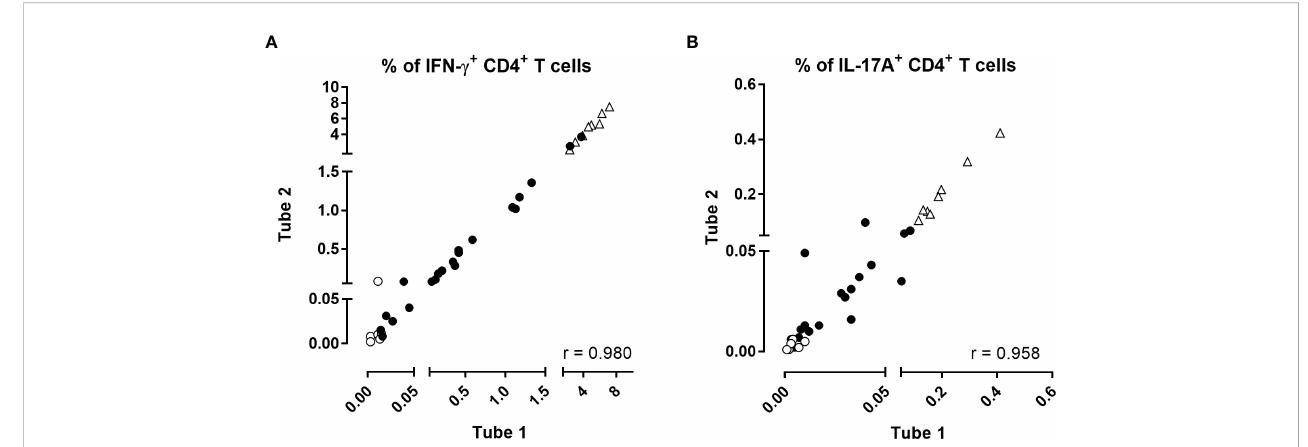
FIGURE 2 Intra-assay reproducibility of the BpWB-ICS assay. The percentages of (A) IFN- g - and (B) IL-17A-producing CD4 + T cells obtained after direct staining of two separate aliquots of blood were compared two by two for each stimulation condition. Two different aliquots (400µl/aliquot) from single blood samples were assayed separately from stimulation until the direct staining of the cells. Negative (no antigen, open circles) and positive (SEB, open triangles) controls were used in parallel to blood incubated during 24 hrs with 5 µg/ml PT, 5 µg/ml FHA, 10 µg/ml BPL, 10 µg/ml Bp sonicate or 10 µg/ml TT (black circles). Thirty- fi ve comparisons were performed on fi ve adults (n°1-5), two of which recently aP boosted, two aP boosted less than three years before, and one, six years before. For the two subjects recently boosted, blood was collected before and after aP booster vaccination. After 24 hrs incubation including a 5 hrs protein transport arrest, the cells were fi xed, directly permeabilized and stained with antibody panel 1 (Table 1). The acquisition was performed on a Canto II fl ow cytometer, and FlowJo software (version 9.5.3) was used for the analysis. Correlations were evaluated by a non-parametric Spearman test with Graphpad Prism 7.03 software (Graphpad software, La Jolla, CA,